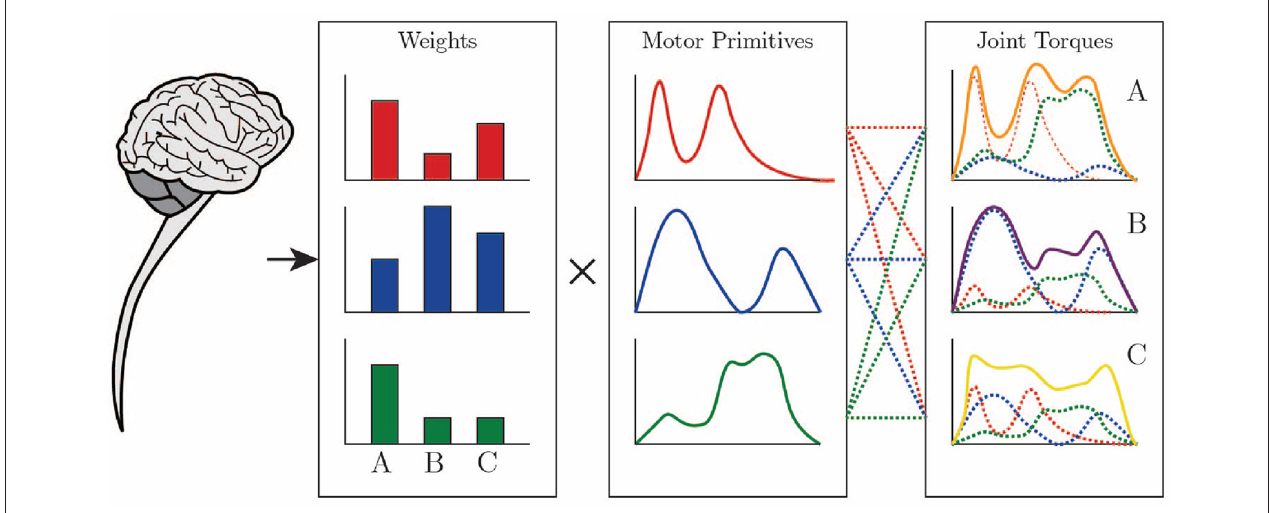
FIGURE 1 | Joint torques are constructed through a weighted sum of motor primitives by the CNS. Drawing based on Ting et al.